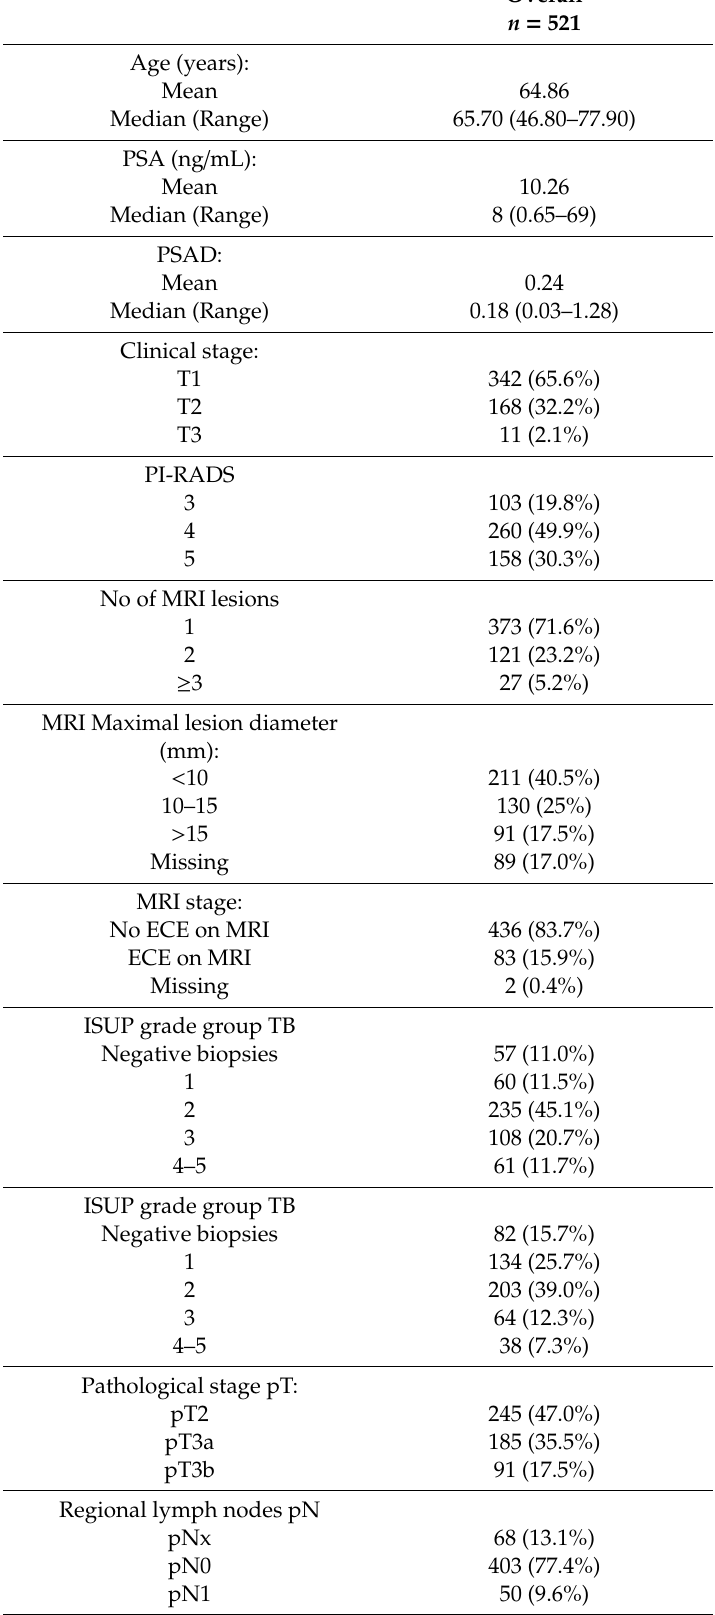
Table 1. Patient